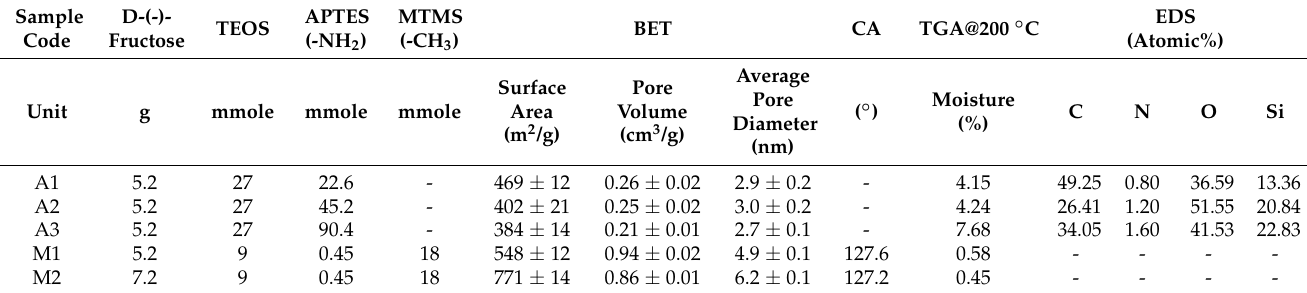
Table 1. Formulation and analytical data of the BET, CA, TGA, and EDS for the hydrophilic MSPs of A1, A2, and A3 as well as the hydrophobic MSPs of M1 and M2.